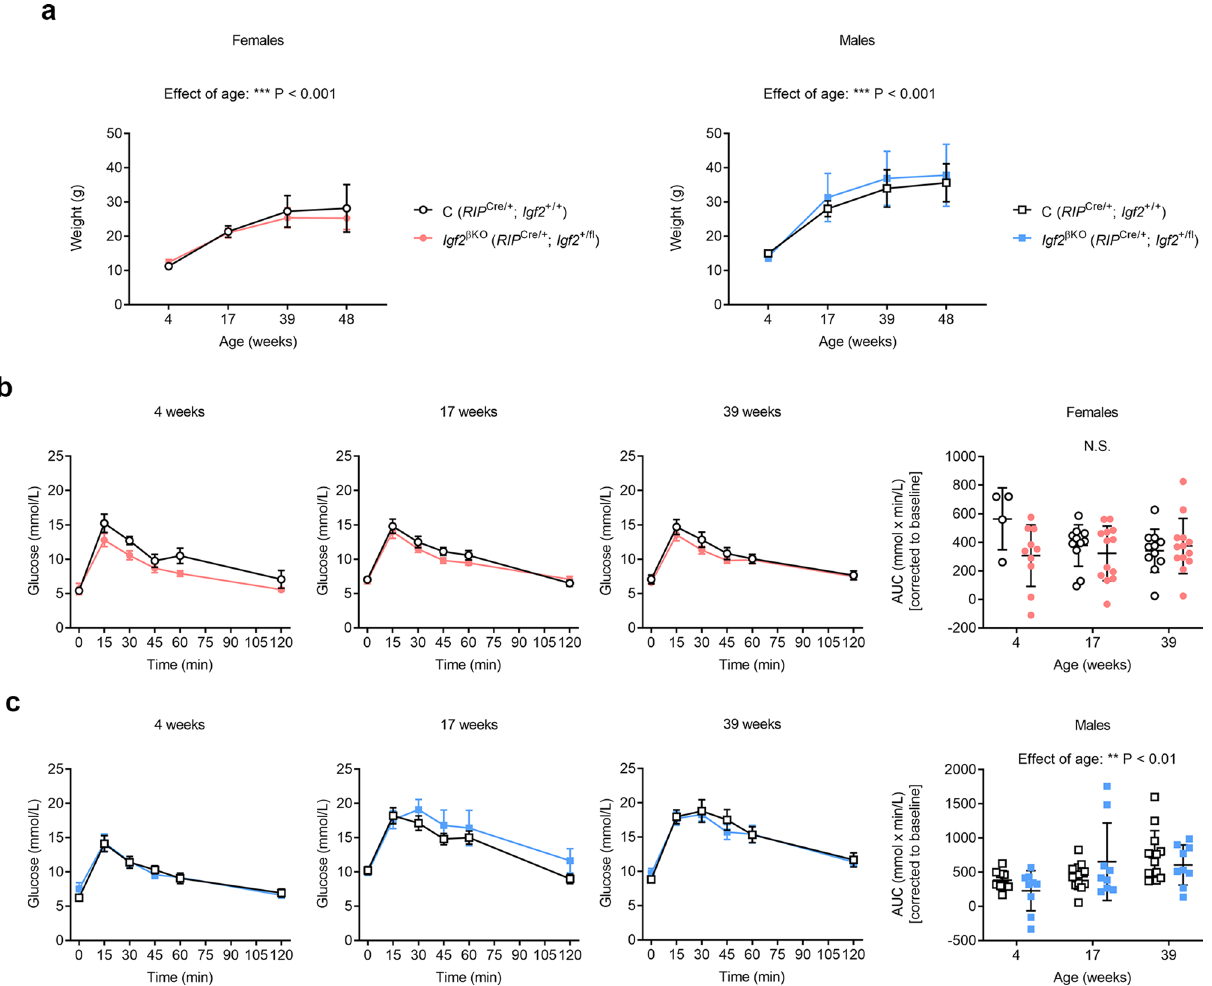
Figure 2. Impact of Igf2 βKO on body growth and glucose homeostasis in adult mice fed a standard chow diet. ( a ) Growth kinetics (n = 4–13 females/genotype and n = 8–13 males/genotype). Glucose tolerance tests with glucose administered by intra-peritoneal injections (ipGTTs) after over-night fasting performed in females ( b ) and males ( c ). First three panels show changes in blood glucose concentrations (y-axis), from basal pre- treatment values, with time (x-axis), after glucose administration. The graphs on the far right in ( b ) and ( c ) show area under curve (AUC) calculated during ipGTTs using the trapezoid rule and normalised to basal glucose levels (n = 4–13 females/genotype and n = 8–13 males/genotype). Data is presented as averages ± SD [panel ( a )] or SEM [first three panels in ( b ) and ( c )] or individual values with averages ± SD [fourth panel in ( b ) and ( c )]. P values shown above graphs were calculated by mixed-effects model tests [panel ( a )] or two-way ANOVA tests [panels ( b ) and ( c )]. NS